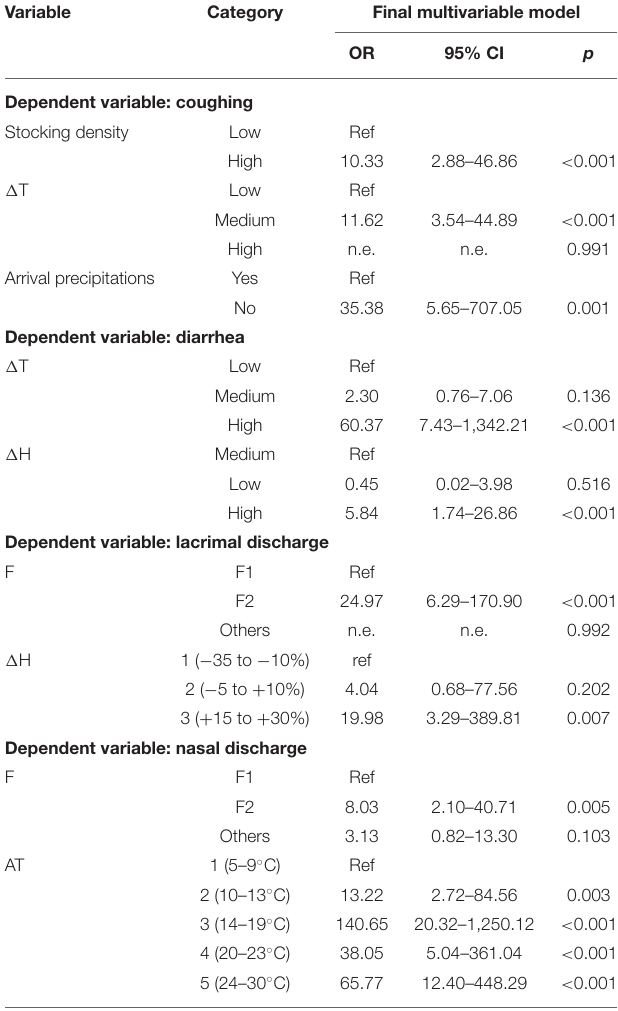
TABLE 4 | Final multivariable regression models for the dummy dependent variables of the presence/absence of clinical signs.